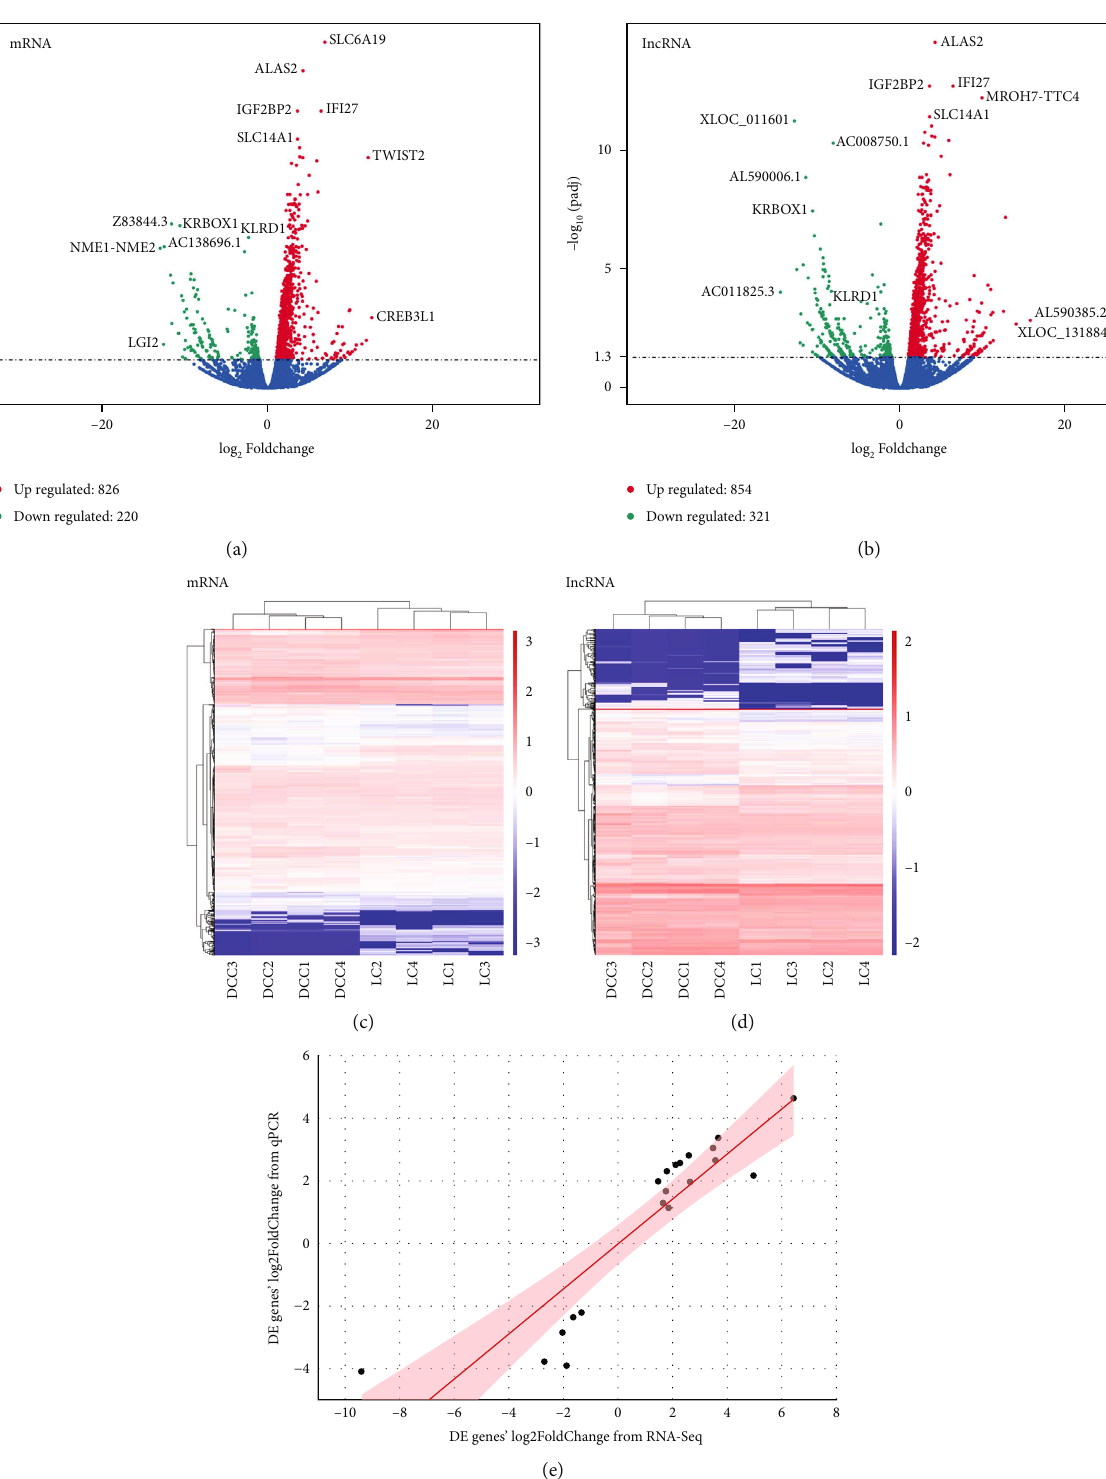
Figure 1: Overview of di ff erentially expressed mRNAs and lncRNAs in PBMCs of decompensated cirrhosis patients (DCC) and liver cirrhosis controls (LC). (a) Di ff erentially expressed mRNAs between the DCC group and the LC group. (b) Di ff erentially expressed lncRNAs between the DCC group and the LC group. (c) Two-way clustering heatmap of the di ff erentially expressed mRNAs. (d) Two- way clustering heatmap of the di ff erentially expressed lncRNAs. (e) Correlation of log2 fold change between RNA-seq and RT-qPCR for signi fi cantly di ff erentially expressed